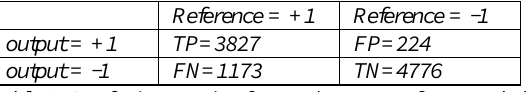
Table 1. Confusion matrix of cross dataset test for